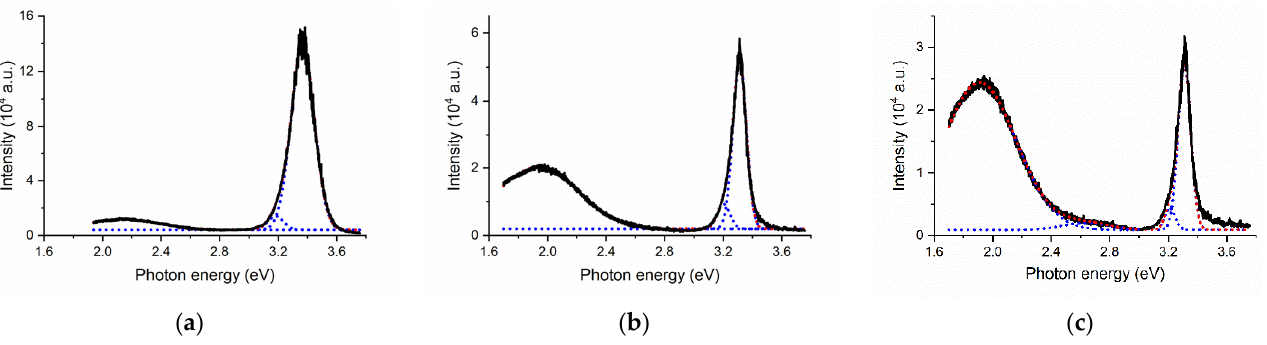
Figure 6. Fitting of the PL spectra with multi-peak Gaussian function ( a ) as-grown nanorods and nanorods annealed at ( b ) 350 °C ( c ) 600 °C after H + ion irradiation. The solid lines are the experimental results. The dotted blue lines represent the Gaussian fitting of the different transition emission and the red line their sum.